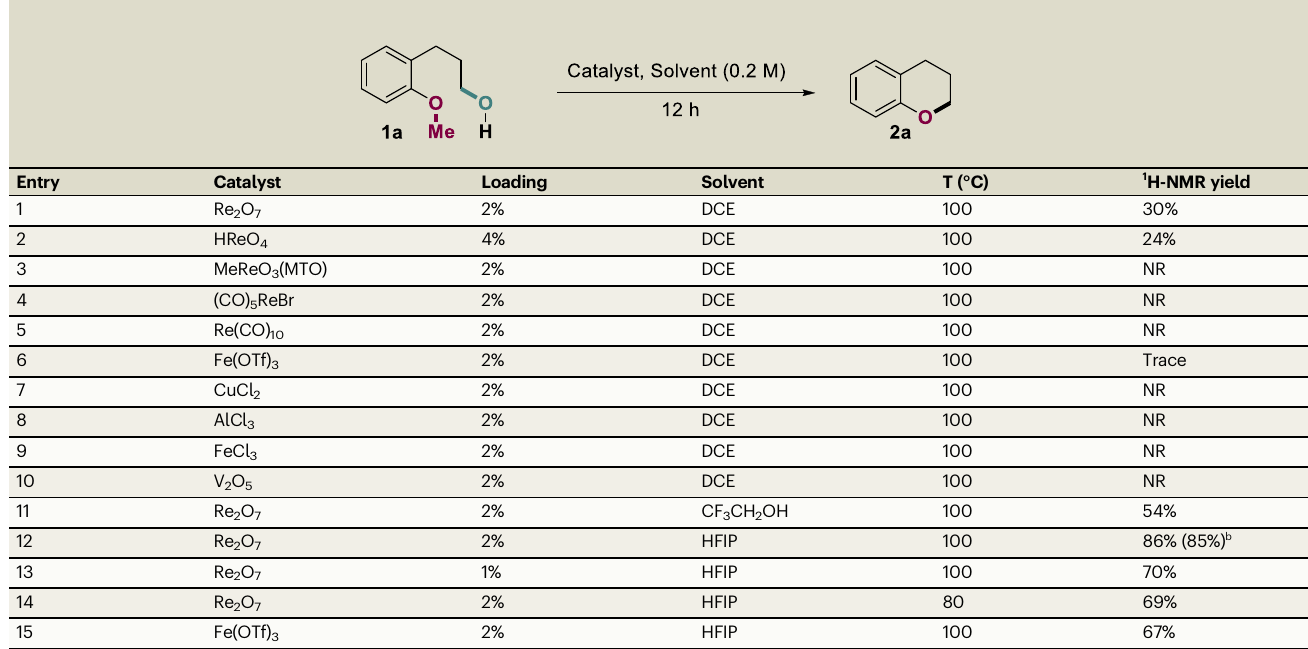
Table 1 | Optimization of the reaction condition